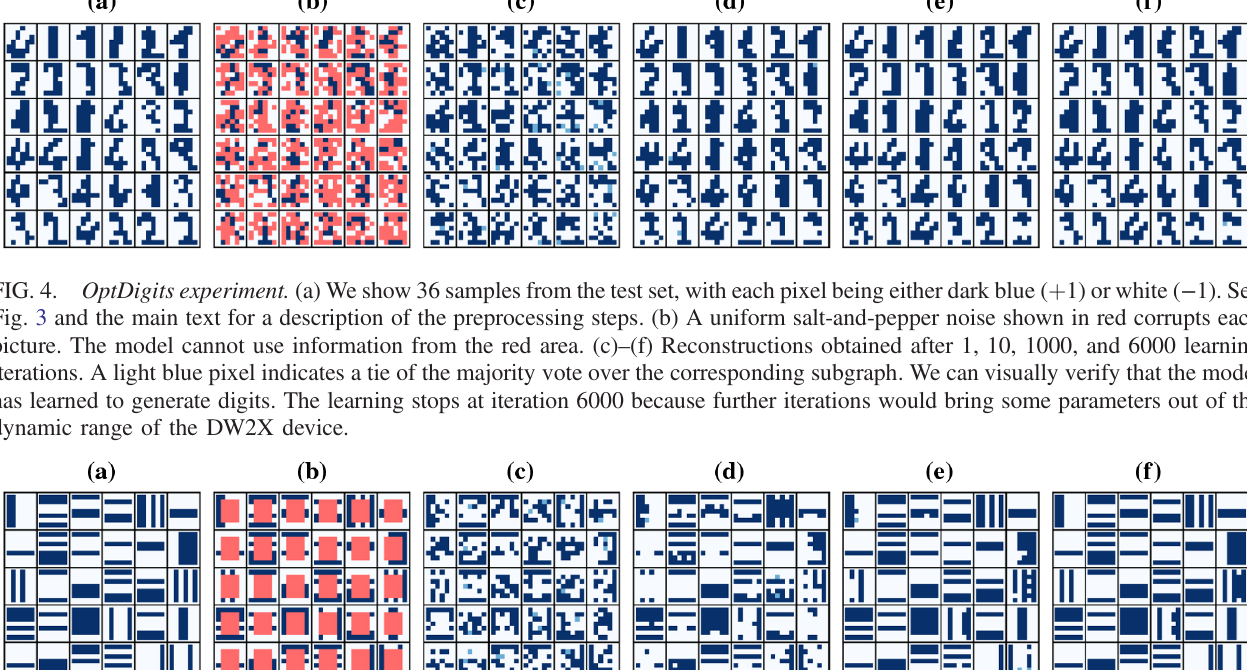
f − 1 ; þ 1 g in order for the data to be represented by qubits in the DW2X. Figure 4(a) shows some pictures from the test set.